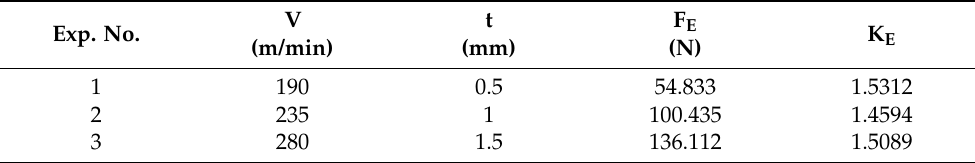
Table 4. The cutting force and chip shrinkage coefficient in primary